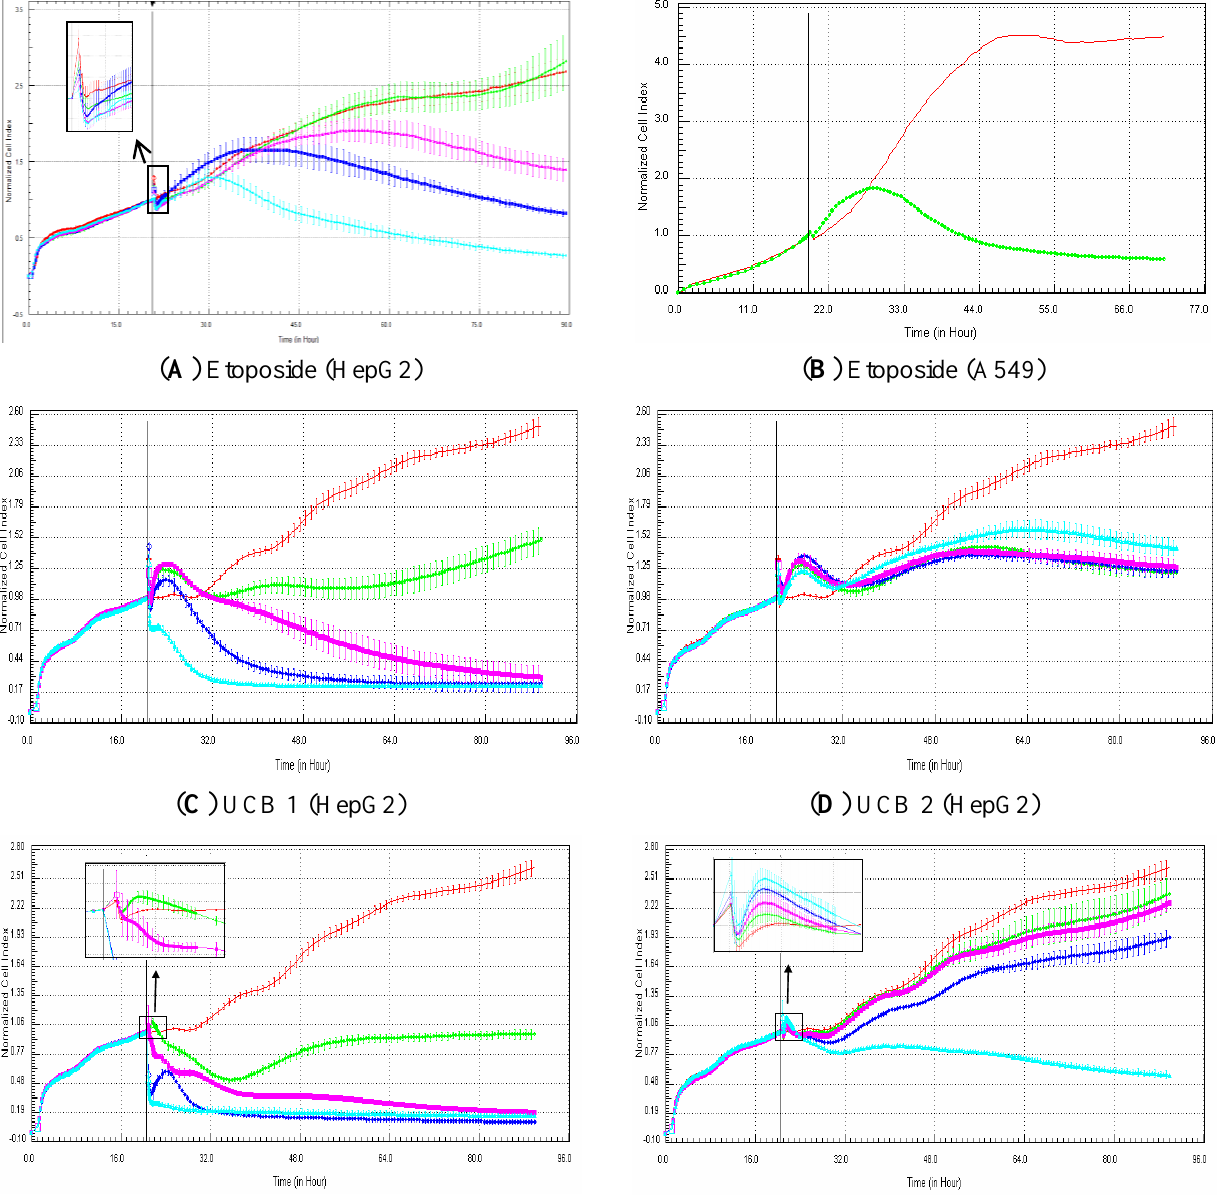
Figure 7. Example of RTCA profiles generated with etoposide (A549 and HepG2 cells) and proprietary UCB compounds (HepG2 cells). ( A ) HepG2 cells were exposed to: 0 (0.5% DMSO, red curve), 0.1 (green curve), 1 (purple curve), 10 (dark blue curve) and 100 (light blue curve) µM of etoposide. ( B ) A549 cells exposed to 0 (control DMSO, red curve) and 20 µM (green curve) of etoposide (Abassi et al . [9]). ( C – F ): HepG2 cells were exposed to 0 (0.5% DMSO, red curve), 125 (green curve), 250 (purple curve), 500 (dark blue curve) and 1,000 (light blue curve) µM of compound UCB 1, 2, 3 and 4, respectively. Cell indexes were normalized with the last time point before compound addition. The normalized time point is indicated by the vertical line. All panels (except B): each data point was calculated from triplicate values (except for control cells n = 6). Data represent the average ± standard deviation (except for panel B). A zoom is provided in case of overlapping curves. For more details, please refer to the Materials and Methods